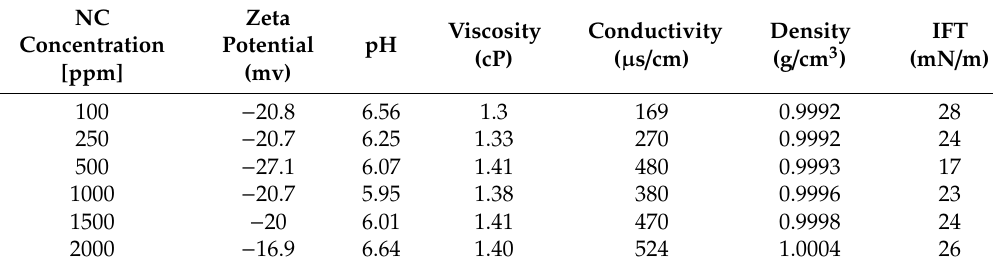
Table 3. Properties of the nanofluid prepared with di ff erent concentrations of the novel